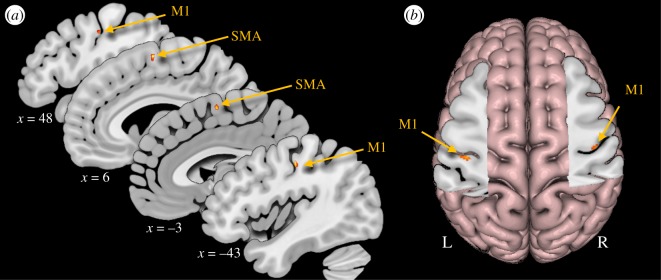
Activations from random-effects analyses for phonation. (a) Sagittal slices showing all activations from the contrast phonation versus rest. (b) The cut-out shows axial slices at the level of z = 45 and 41, in the left and right hemisphere, respectively. M1, primary motor cortex; SMA, supplementary motor area.